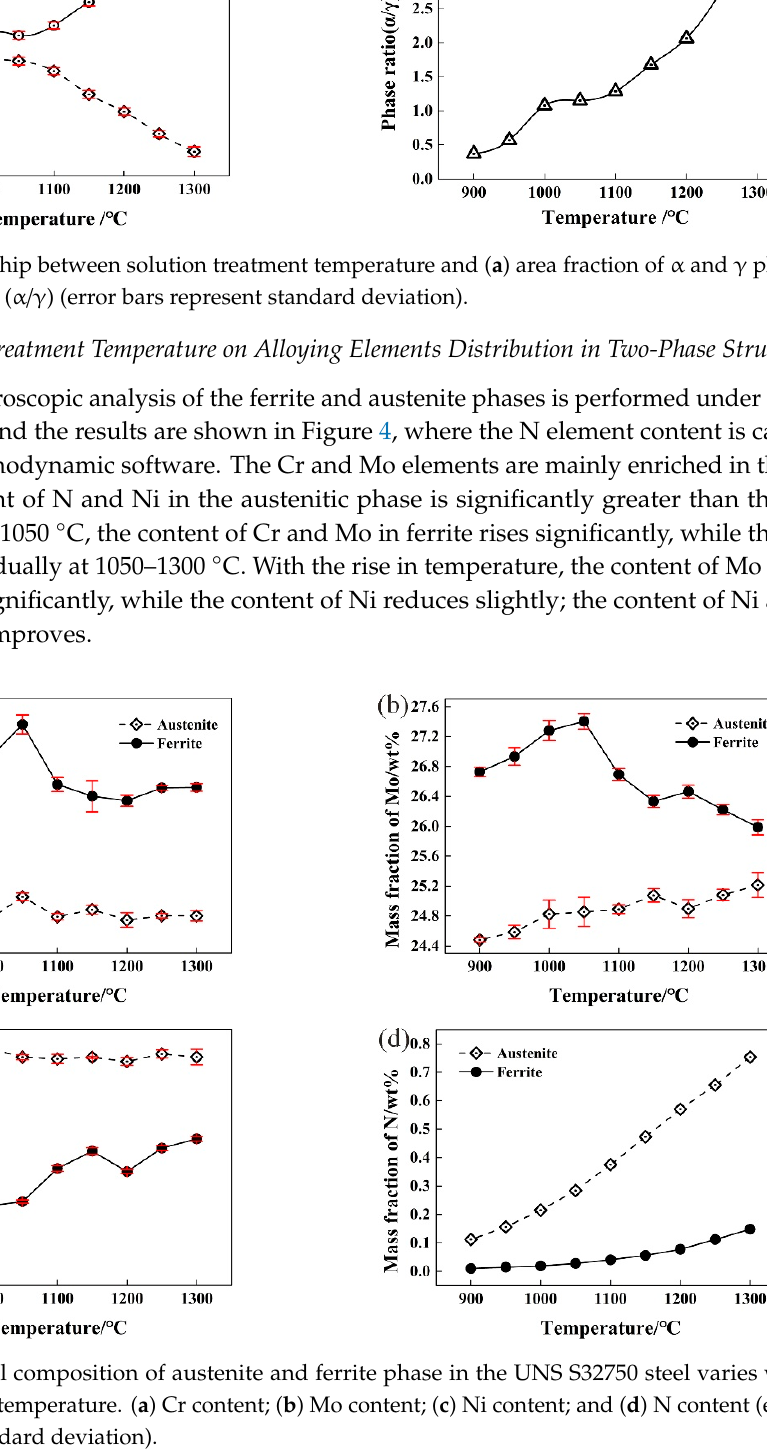
Figure 2. Microstructures of the UNS S32750 super duplex stainless steel treated at different solution treatment temperatures. ( a ) 900 °C; ( b ) 1000 °C; ( c ) 1050 °C; ( d ) 1100 °C; ( e ) 1200 °C; and ( f ) 1300 °C.